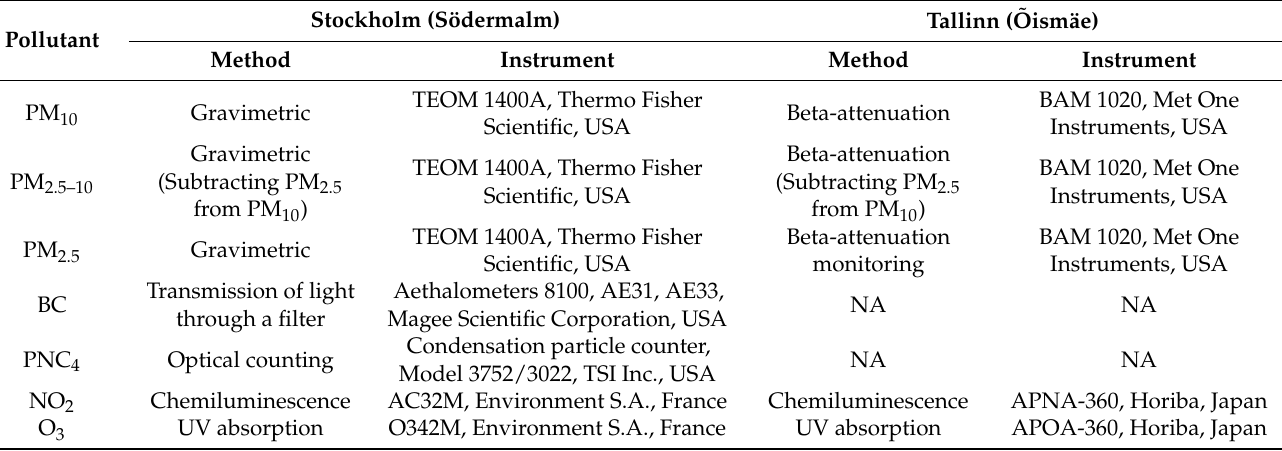
Table 1. Description of the measurement methods and the instruments that were used to measure the pollutants in Stockholm and Tallinn (NA = not